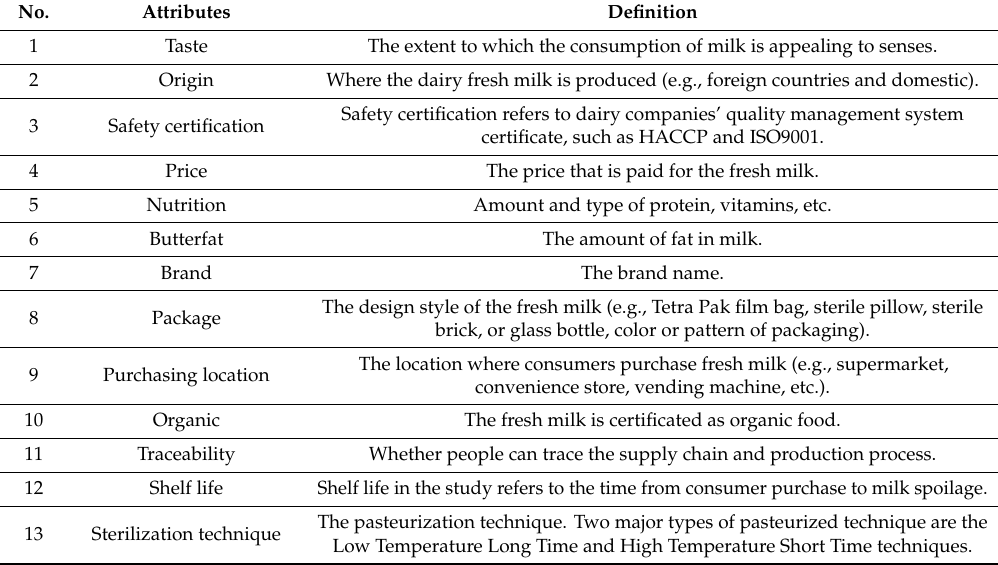
Table 1. Description of fresh milk